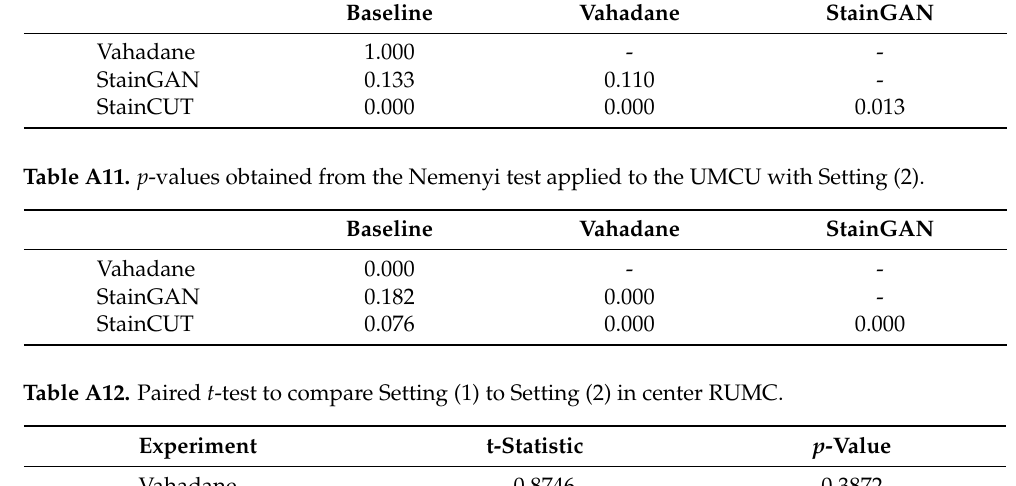
Table A10. p -values obtained from the Nemenyi test applied to the RUMC with Setting (2). Baseline